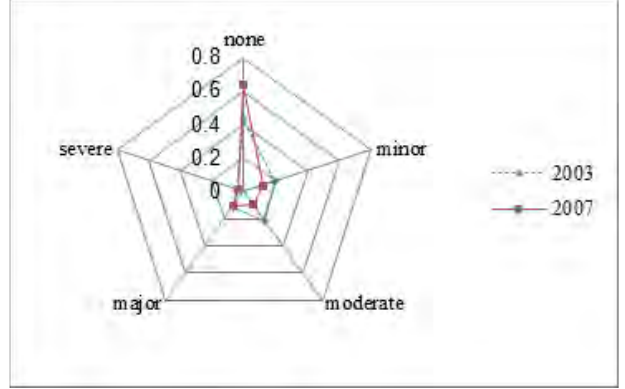
Figure 1: Access to finance 2003 vs. 2007 Source: World Bank Enterprise Surveys of South Africa (2003;